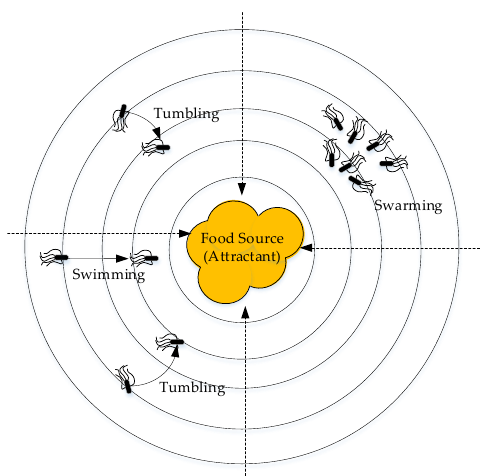
Figure 2. The basic behaviors of bacteria.